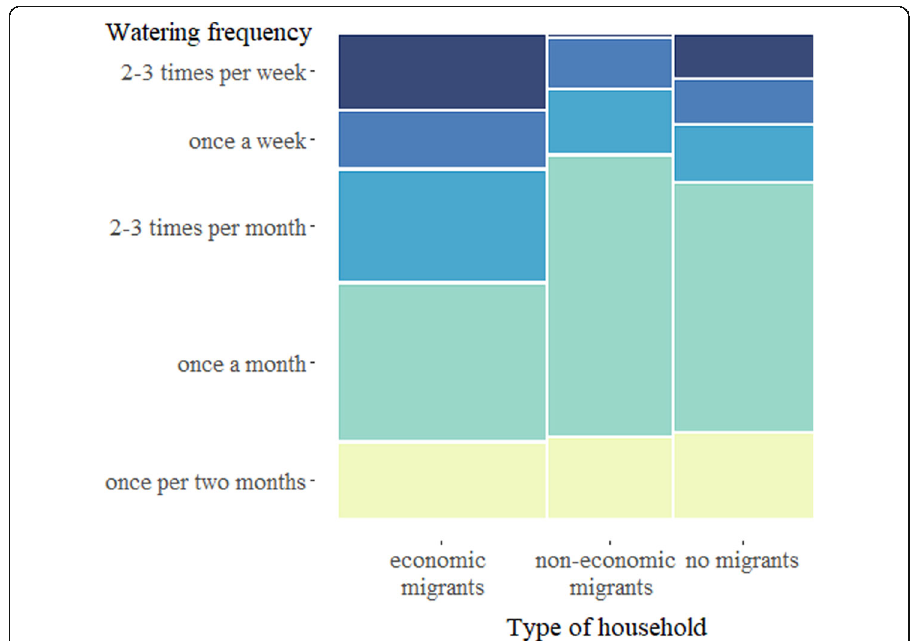
Fig. 4 Watering frequency in different types of